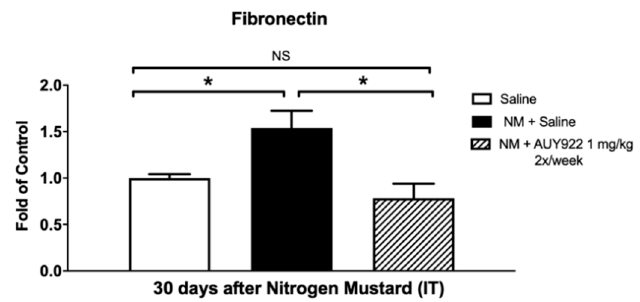
Figure 6. The HSP90 inhibitor, AUY-922, blocks the NM-induced fibronectin production. Total fibronectin mRNA in lung tissue homogenates was determined by real time qPCR, as described in the Methods. Mice received 0.625 mg/kg NM or saline (2 μ L/g body weight, intratracheally) on day 0. They then received AUY-922 (1 mg/kg, 2×/week intraperitoneally) for 30 days, starting 24 h after NM. Means ± SEM ; n = 4 mice per group; *: p < 0.05, NS: not significant with ANOVA and Tukey’s.